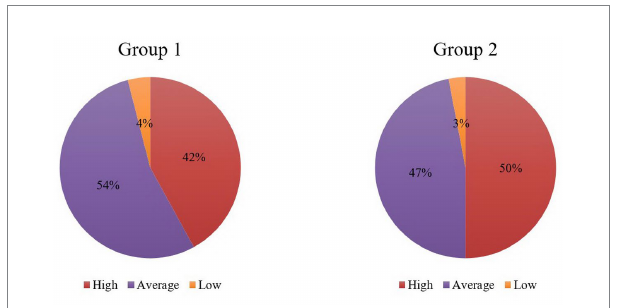
FIGURE 10 Answers to the question: please, rate your motivation for learning (Post-training survey). Source: compiled by the authors.